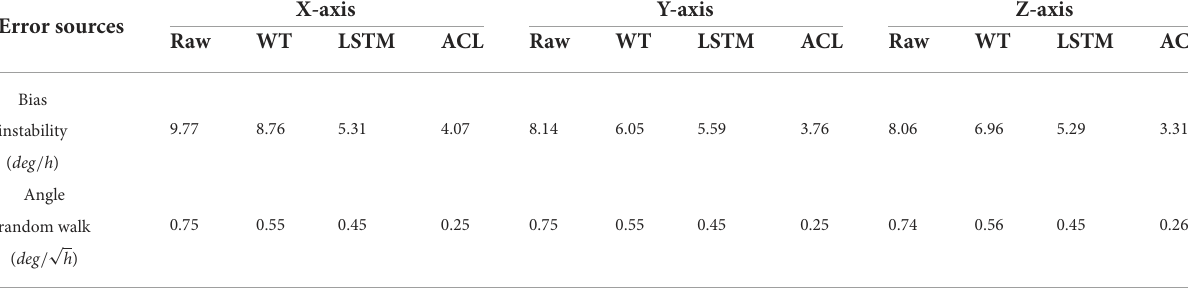
TABLE 3 Allan variance parameters of the AHRS380SA 3-axis